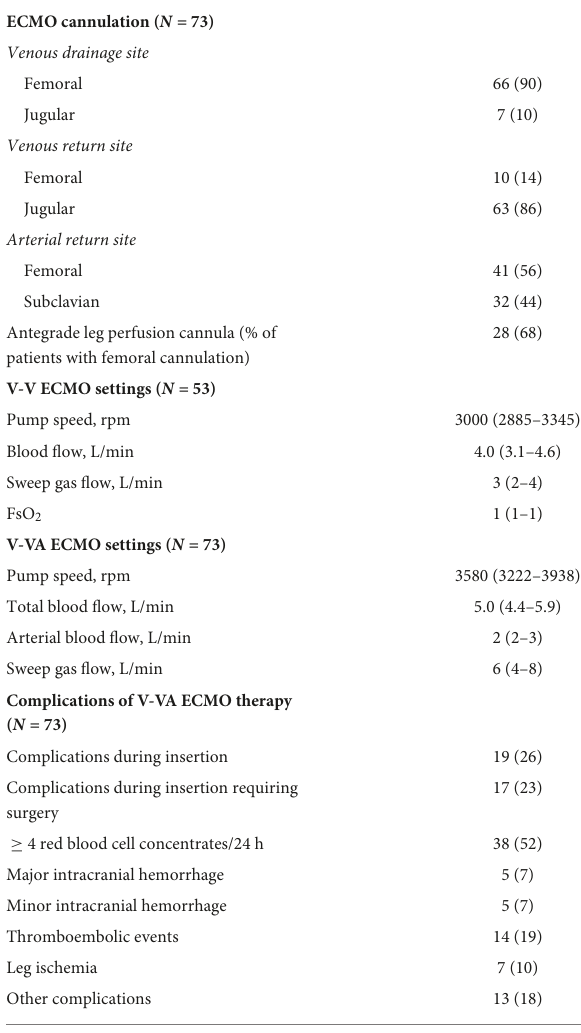
TABLE 3 Extracorporeal membrane oxygenation (ECMO) configuration, setting and